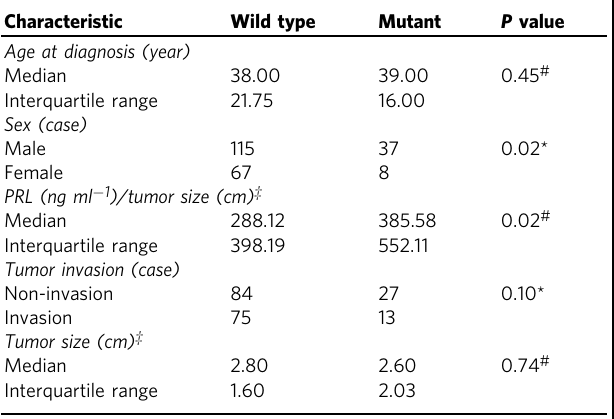
Age and sex data were available for 182 patients with no mutation and 45 patients with the mutation. PRL/tumor size, tumor invasion, and tumor size data were available for 159 patients with no mutation and 40 patients with mutation. In total, 28 cases from the First Af fi liated Hospital of University of Science and Technology of China were excluded from statistical analysis because of different PRL dilution measurement protocol. # Values were compared by two-tailed Mann – Whitney U test. *Values were compared by Pearson ’ s χ 2 test. ‡ Tumor size: maximal tumor diameter. Source data are provided as a Source Data fi